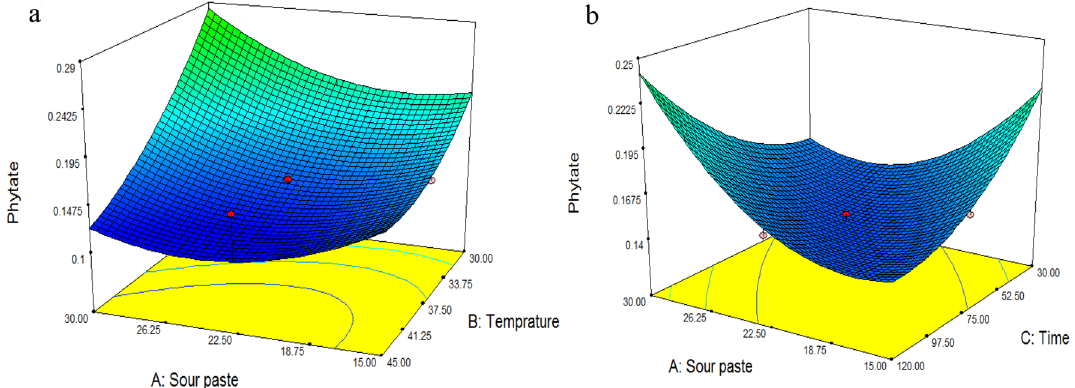
Fig. 4 Effect of temperature and sourdough amount a and fermentation time and sourdough amount b on phytic acid of Barbari bread